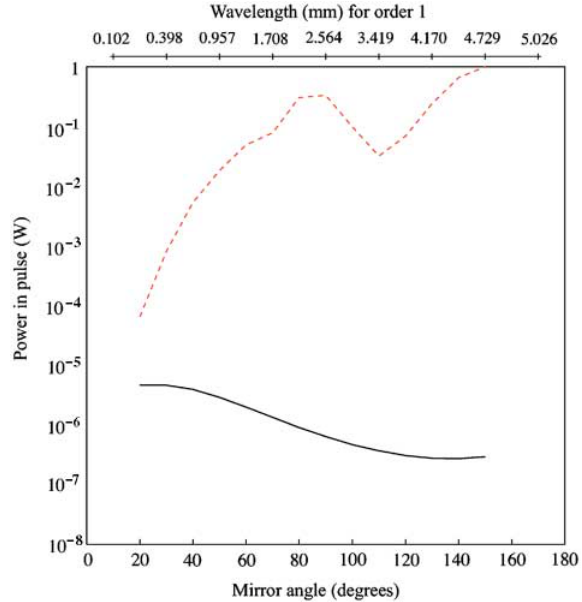
FIG. 4. (Color) Expected incoherent (solid line) and coherent (dashed line) output power levels for an assumed triangular pulse with e (cid:1) 1.1 (see text for details).